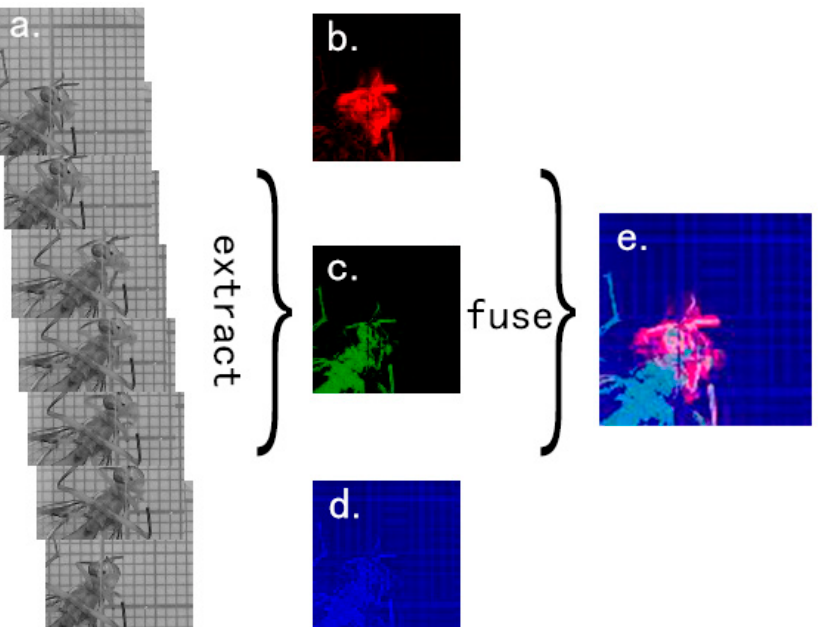
Figure 6. Examples of feature image generation. ( a ) The 7 original gray images based on 7 original RGB frames; ( b ) Temporal features (T-ROI) of Bactrocera minax generated by 7 frames time window based on Figure 6a; ( c ) Spatial information (S-ROI) of Bactrocera minax extracted by the second image in Figure 6a; ( d ) Static information generated after normalization of the gray value of the second image in Figure 6a; ( e ) The final feature image which contains temporal features, spatial information, and static information.